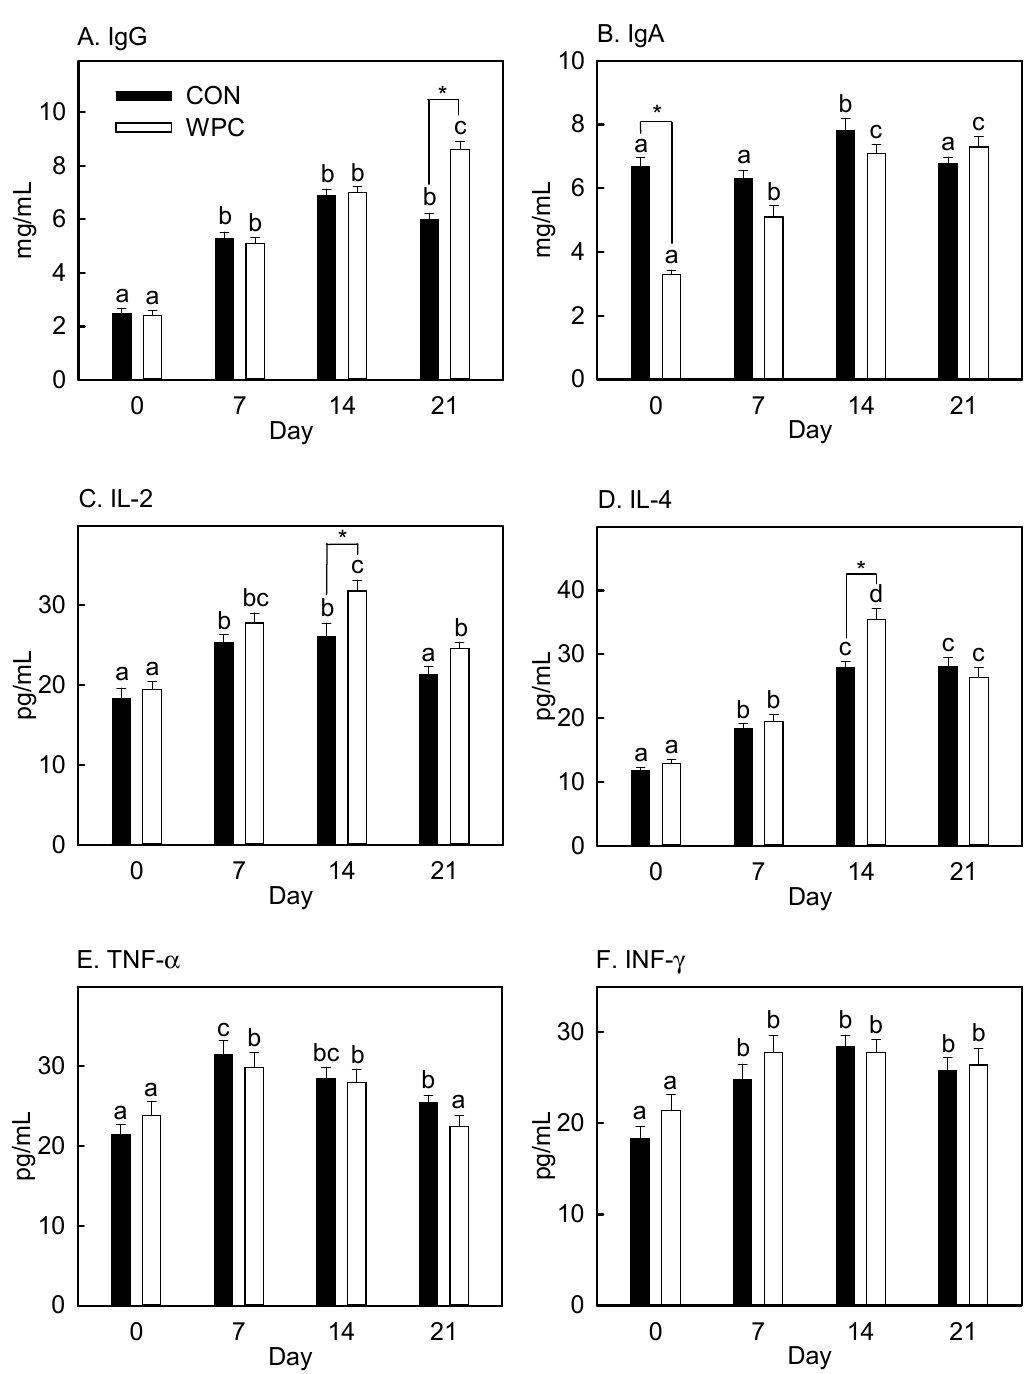
Figure 2. Changes in plasma immunoglobulins and cytokines concentrations in rats after antigen injection. Values are expressed as mean ± S.E. ( n = 5). IgG, immunoglobulin G; IgA, immunoglobulin A; IL-2, interleukin-2; IL-4, interleukin-4; TNF- α , tumor necrosis factor- α ; INF- γ , interferon- γ . * Significantly different when compared with CON on an identical Day by Student t -test ( P < 0.05). a,b,c,d Significantly different compared with Day 0 of each dietary treatment by ANOVA and Fisher’s least significant difference test ( P < 0.05).